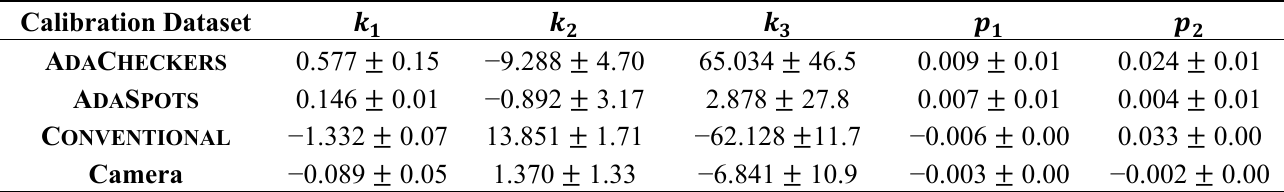
Table 3. Calibrated nonlinear intrinsic parameters with standard